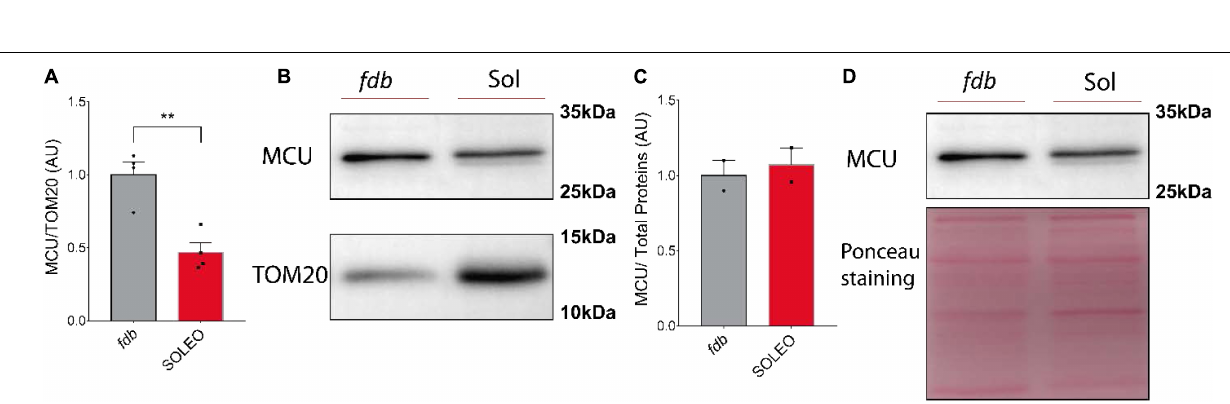
FIGURE 5 | Mitochondria from Flexor Digitorium Brevis ( fdb ) muscle presented a higher content of MCU protein than soleus (sol) muscle. Representative Western Blot and quantification show the levels of the MCU protein in homogenates of fdb and Sol normalized by mitochondrial content using TOM20 as a normalizing protein ( n = 4) (A,B) . When MCU content was normalized by total protein content, no differences between these two muscles were observed ( n = 2) (C,D) . Values are presented as mean ± S.E.M. Values are presented as mean ± SEM. * p < 0.05; ** p < 0.01; *** p < 0.001.